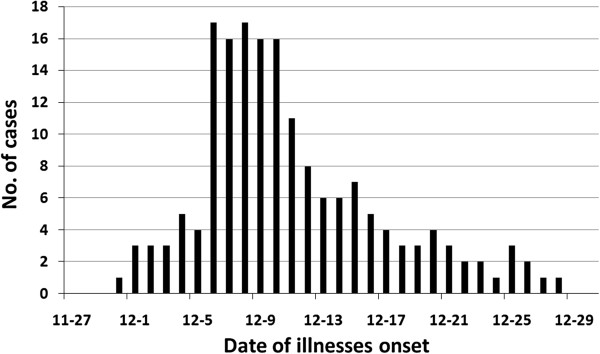
Epidemic curve of the HMFD outbreak in Linyi City, Shandong Province, China, 2010.